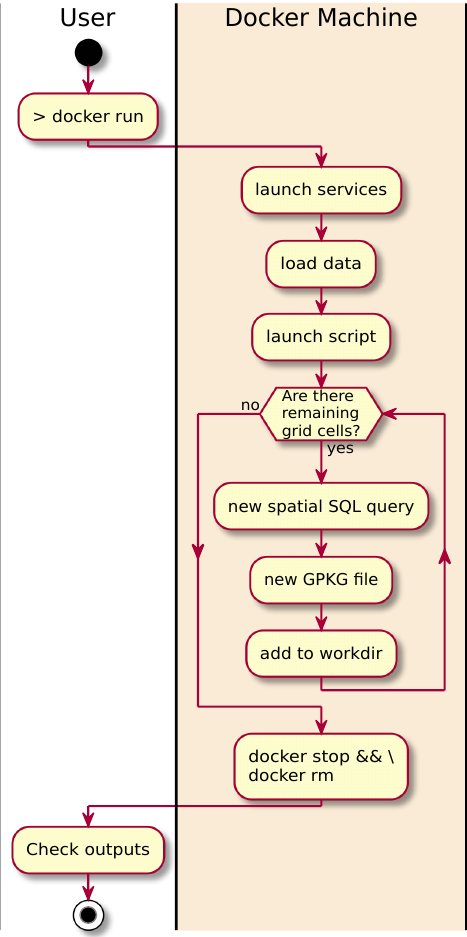
Figure 5. UML activity diagram showing all the tasks automated in the SIOSE-splitter